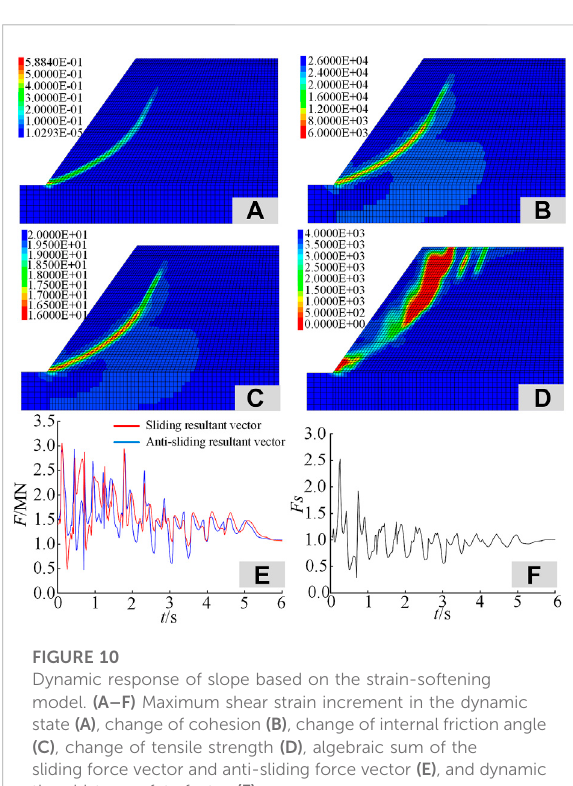
sum method to obtain the time history safety factor curve and stability evaluation results of the seismic slope. the static condition, the maximum shear strain increment is 0.015, with only local damage in the slope foot, as shown in Figure 9A. Under the action of the dynamic load, according to the critical slip surface shown in Figure 8A, the dynamic response law of the seismic slope is calculated by the vector sum method, as shown in Figures 9B – D. It can be seen that the local damage of the seismic slope extends to the inside, compared to the static conditions, and the maximum shear strain increment increases to 0.061. During the seismic dynamic process, the minimum safety factor is 0.30, and the maximum safety factor is 2.40. The corresponding times are 0.56 and 1.22 s, respectively. After the action of dynamic load, the fi nal safety factor of a seismic slope tends to be 1.19, which is not much different from the factor before the dynamic load.